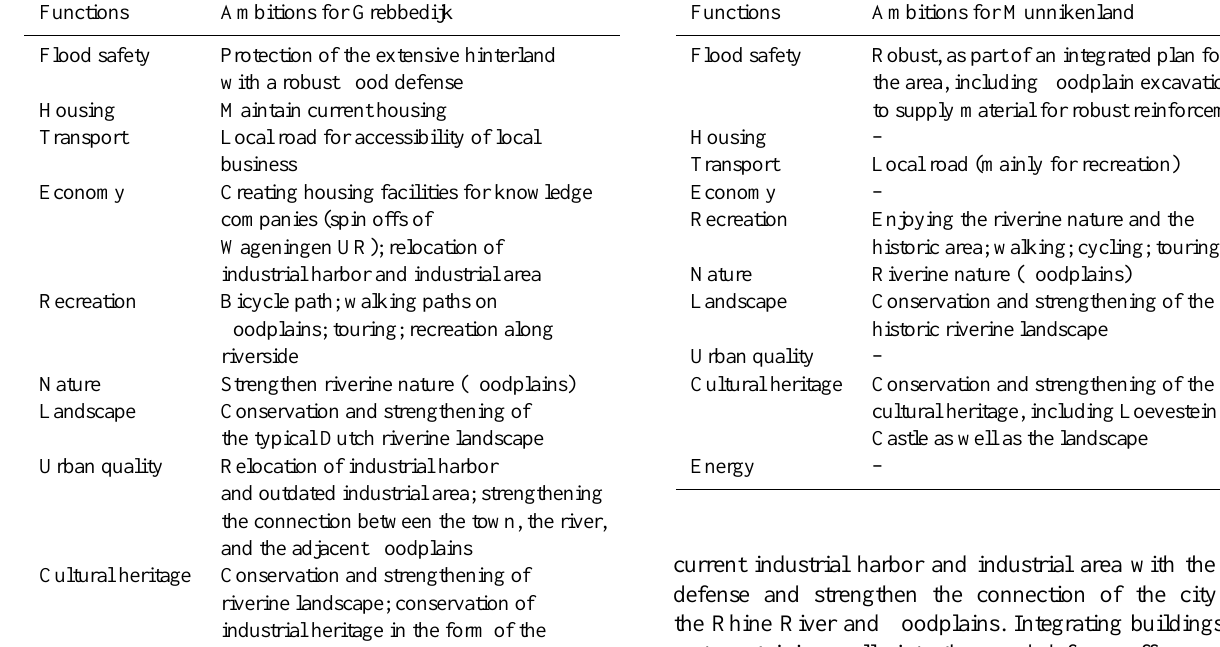
Table 6. Envisaged functions for the Grebbedijk location. Functions